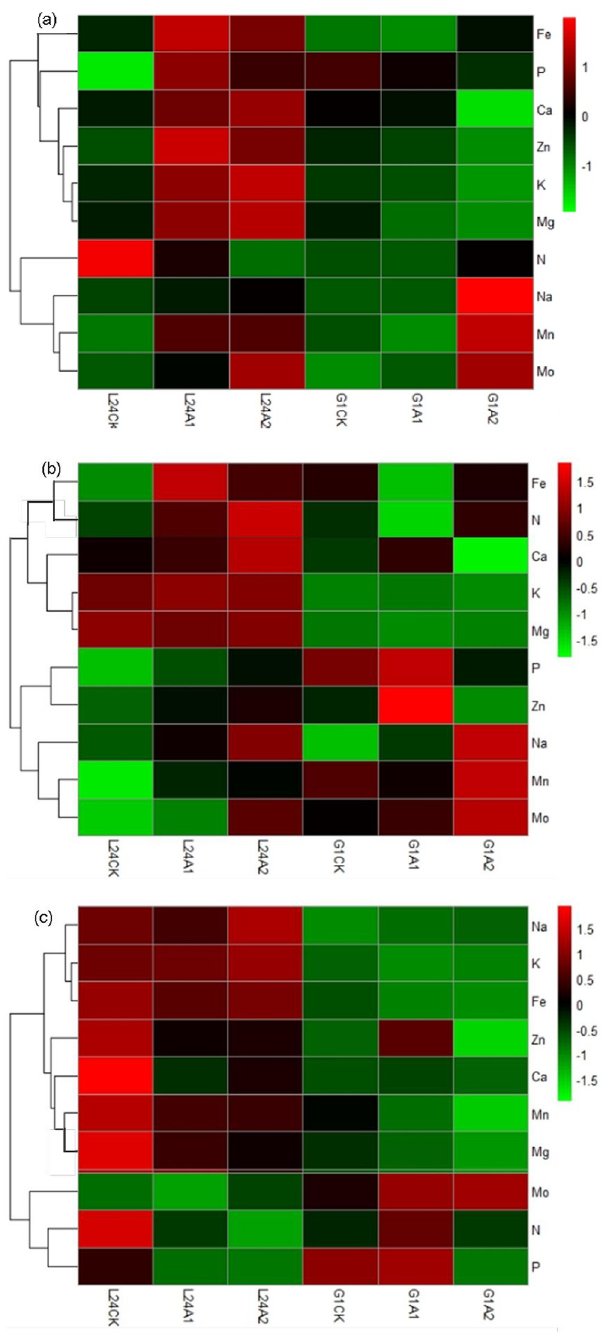
Fig 4. Hierarchical cluster analysis of element concentrations in leaves (a), stem (b), and root (c) of two cotton varieties (salt-tolerant variety L24, salt-sensitive variety G1) under alkaline stress (A1, A2). The abscissa represents the sample name, and the ordinate represents the elements. Different columns in the figure represent various samples, and rows represent element concentrations. The color represents the level of element concentrations in the sample.